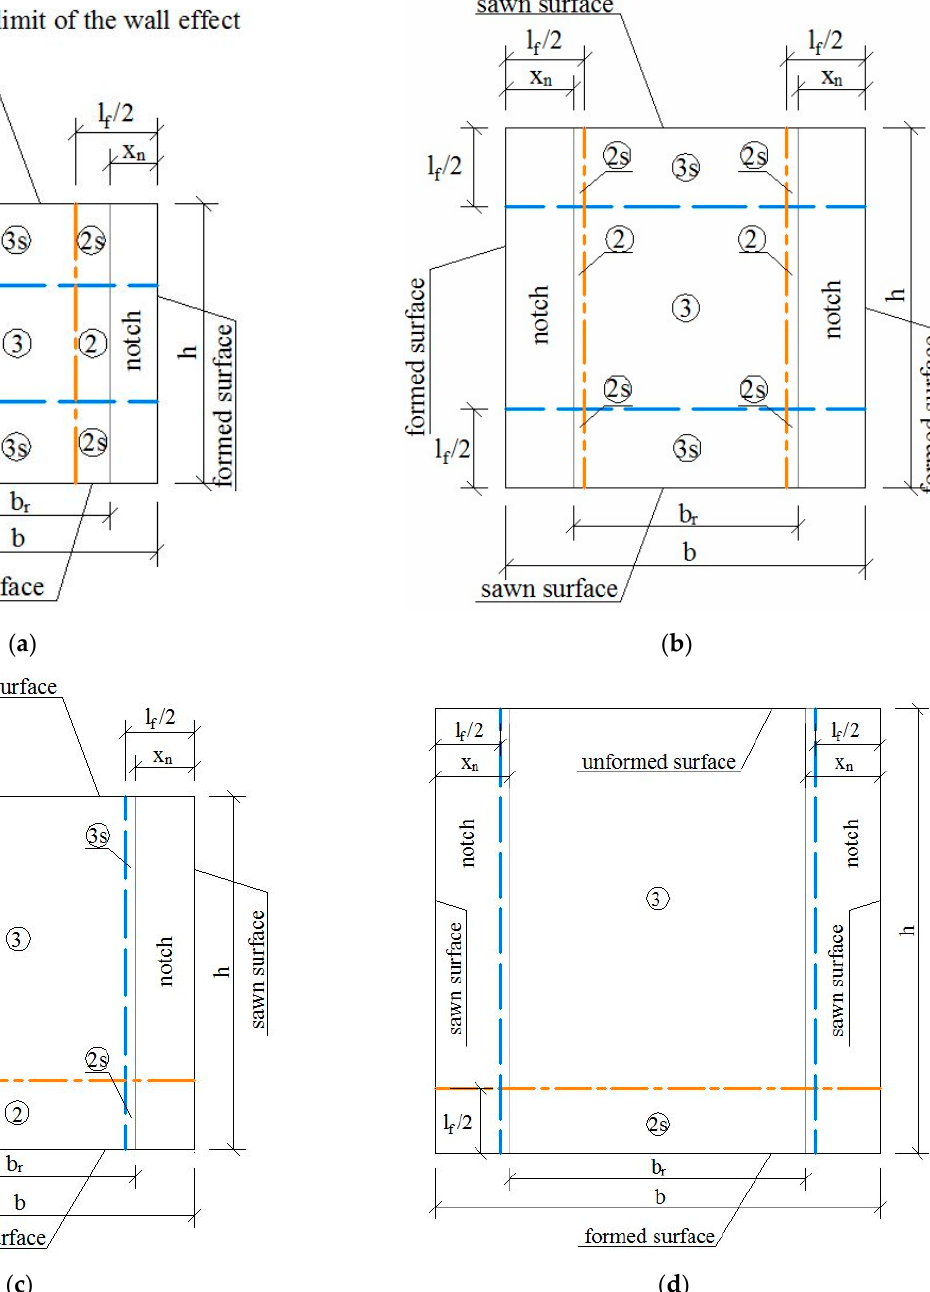
Figure 6. Edge effects of the sawing and wall on the cross-section areas of the prisms from the mock-up: ( a ) 6W, ( b ) 8W, ( c ) 9TF and ( d ) 12TF.